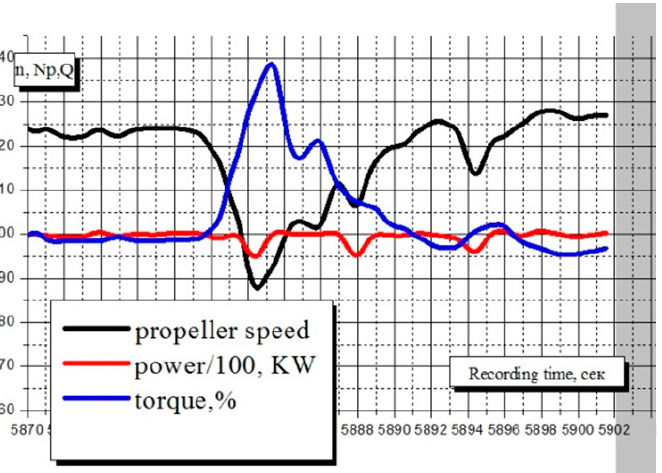
Figure 8. Electric engine torque change due to propeller/ice interaction at design regime at a constant power for a large-capacity tanker, astern mode in ridges [8].